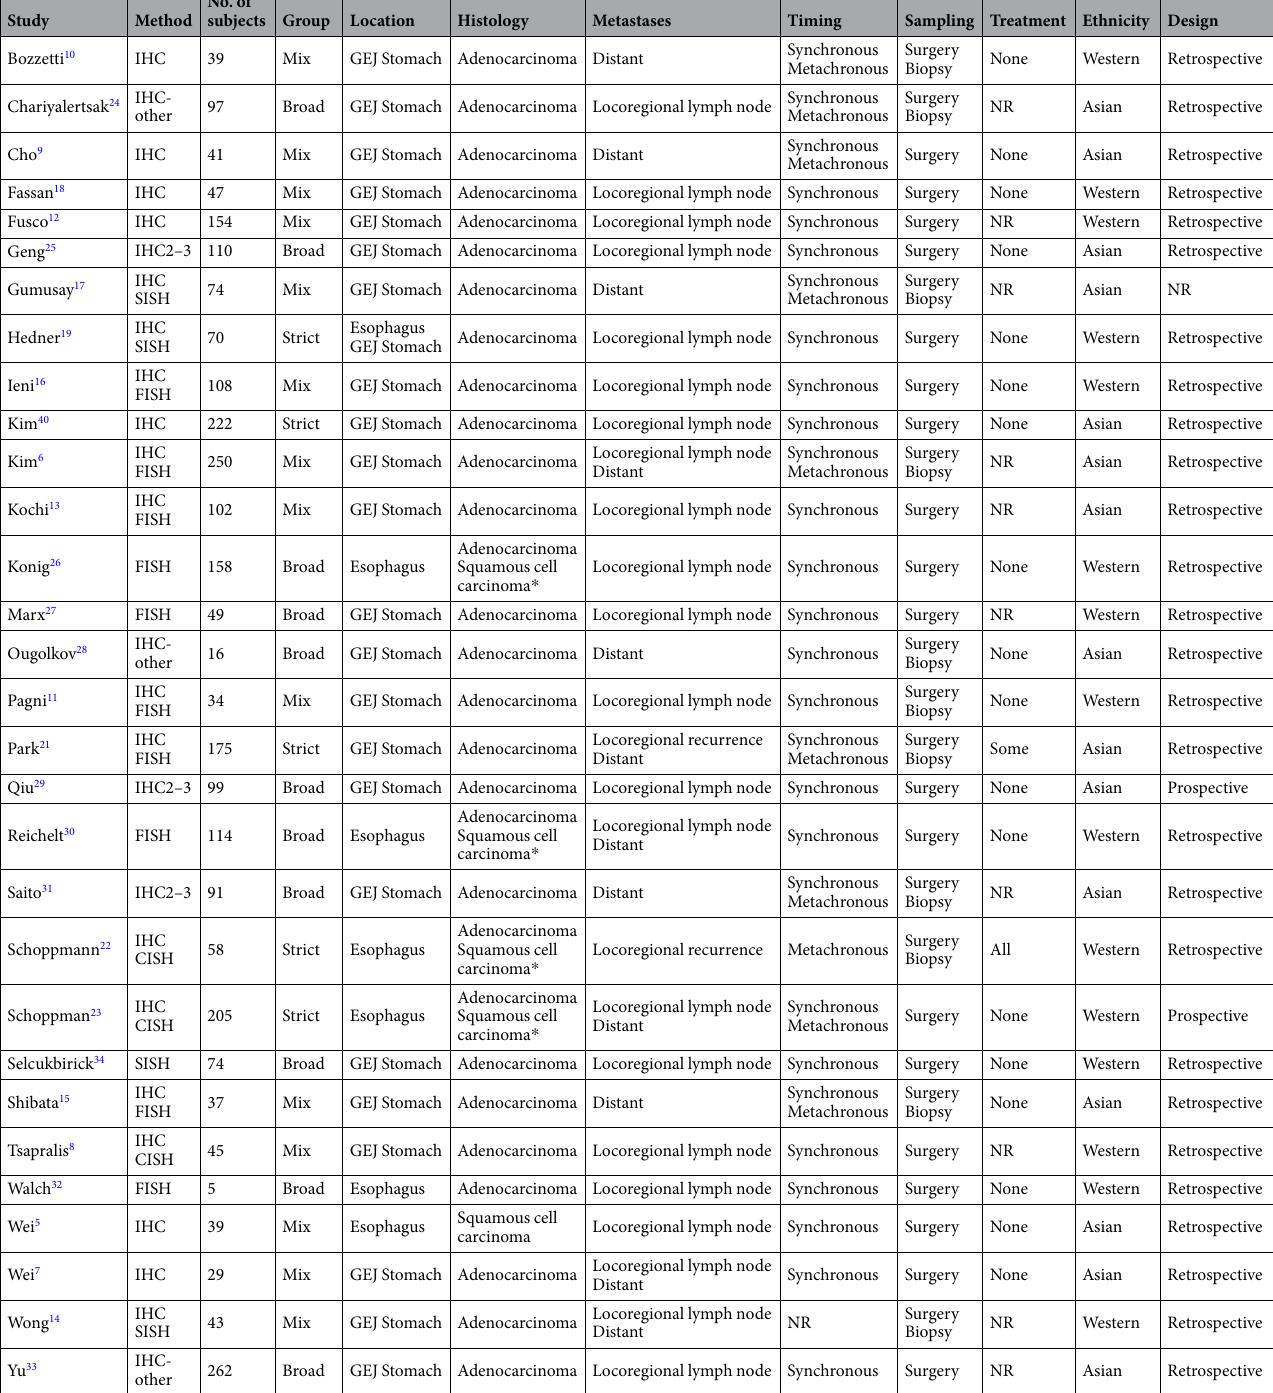
Table 3. Study characteristics of studies included in meta-analysis. GEJ: Gastro-esophageal junction tumors. * : Separate analysis. Abbreviations: CISH: Chromogenic in situ hybridization. FISH: Fluorescence in situ hybridization. SISH: Silver in situ hybridization. IHC: immunohistochemistry. NR: not reported. Strict: include data of HER2 positivity defined as IHC score 3 + or IHC score 2 + with an amplification of the HER2/neu gene by in situ hybridization (ISH). Broad: include IHC scores 2 + and 3 + marked HER2 positive (irrespective of ISH) or amplification of the HER2/neu gene without additional IHC analysis. Mix: Include data of both strict and broad definitions of HER2 status determination; articles used in pair-wise